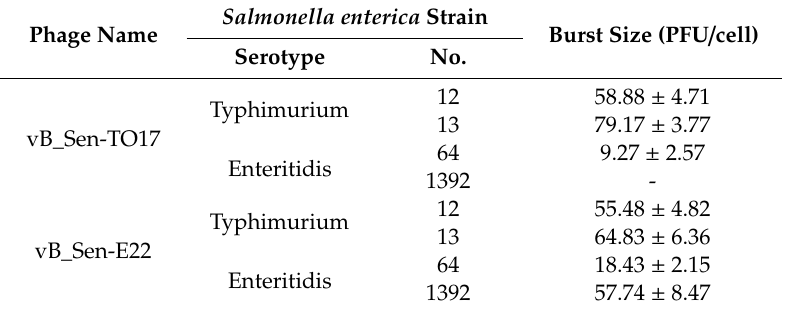
Table 7. Burst size of phages vB_Sen-TO17 and vB_Sen-E22 on di ff erent S. enterica strains at 42 ◦ C. The burst size was calculated from samples untreated with chloroform during the one-step growth experiment. Mean values from three independent experiments with SD are presented.